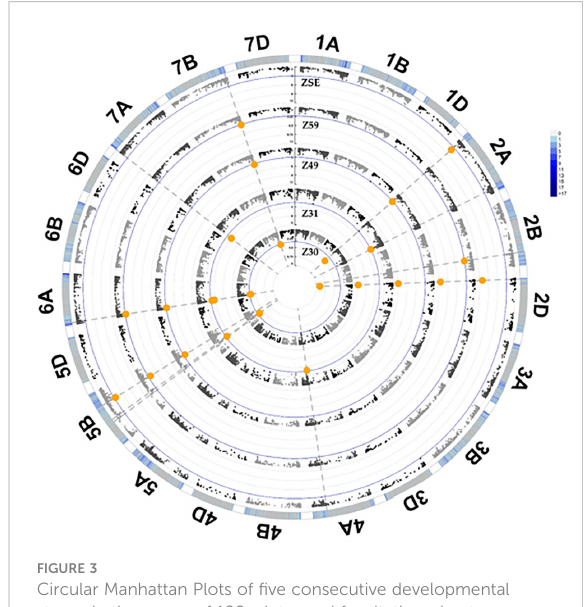
FIGURE 3 Circular Manhattan Plots of fi ve consecutive developmental stages in the group of 188 winter and facultative wheat genotypes; Z30 – start of the intensive stem elongation; Z31 – fi rst node detectable; Z49 – booting; Z59 – heading; ZSE – end of intensive stem elongation. The yellow dots are indicating the most signi fi cant marker-trait associations.